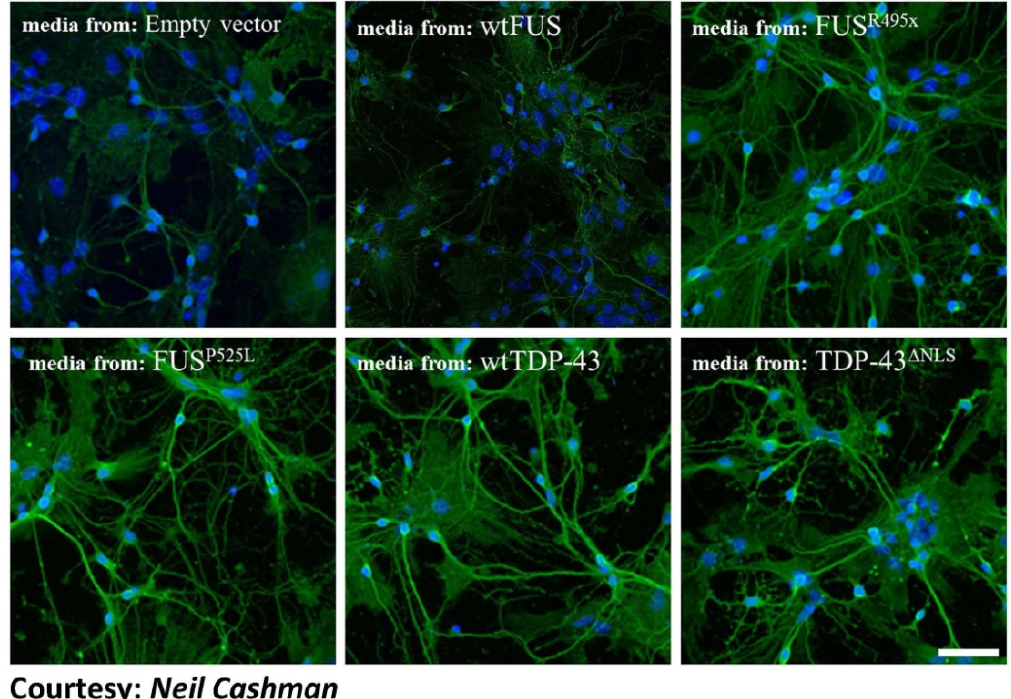
Figure 4. TDP-43 and FUS-induced misfolded HuWtSOD1 propagates from transfected cells to untreated spinal cord cultures. Primary spinal cord cultures containing neurons (including motor neurons) and astrocytes prepared from human HuWtSOD1 transgenic mice were incubated for 20 h with conditioned media from transfected HEK293 cells, and stained for misfolded SOD1 (green) using misfolded SOD1-specific antibody, 3H1, and counterstained using Hoechst 33342 (blue). The source of the media is indicated for each panel. Primary cultures incubated with conditioned media from FUSR495X, FUSP525L, wtTDP-43, and TDP- 43 ∆ NLS showed an increase in the presence of cytoplasmic misfolded SOD1 when compared to cells incubated with conditioned media from cells transfected with empty vector control and wtFUS. Scale bar: 75 µ m. Figure 4 has been